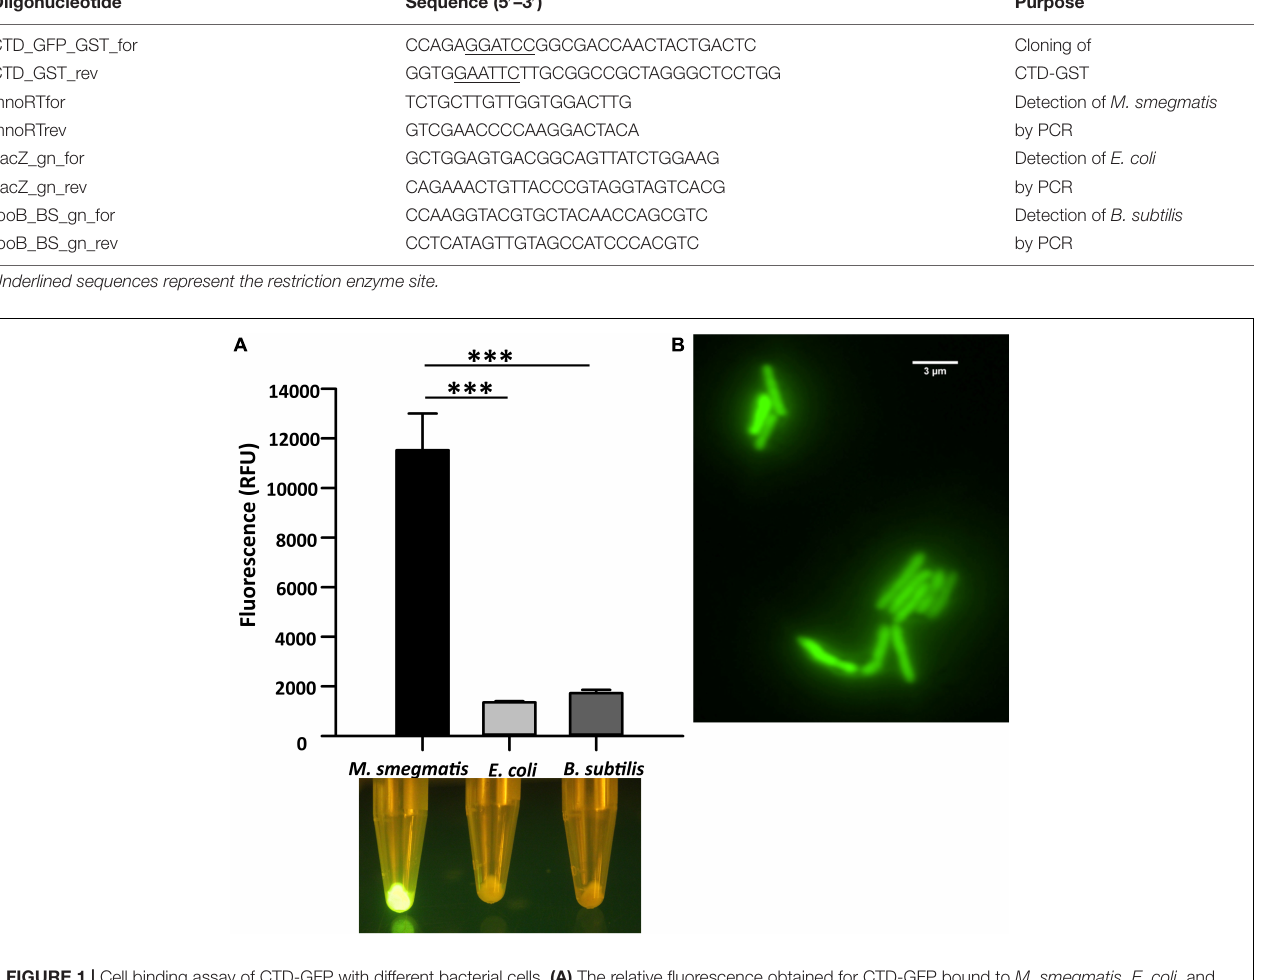
TABLE 2 | List of oligonucleotides used in the present study. Oligonucleotide Sequence (5 (cid:48) –3 (cid:48) )